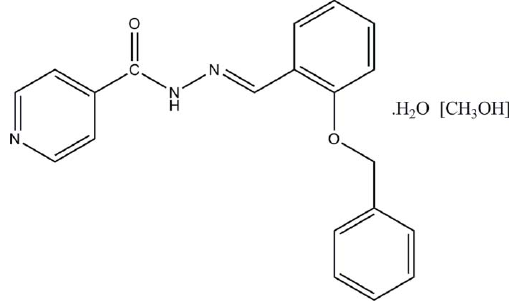
Experimental Crystal data